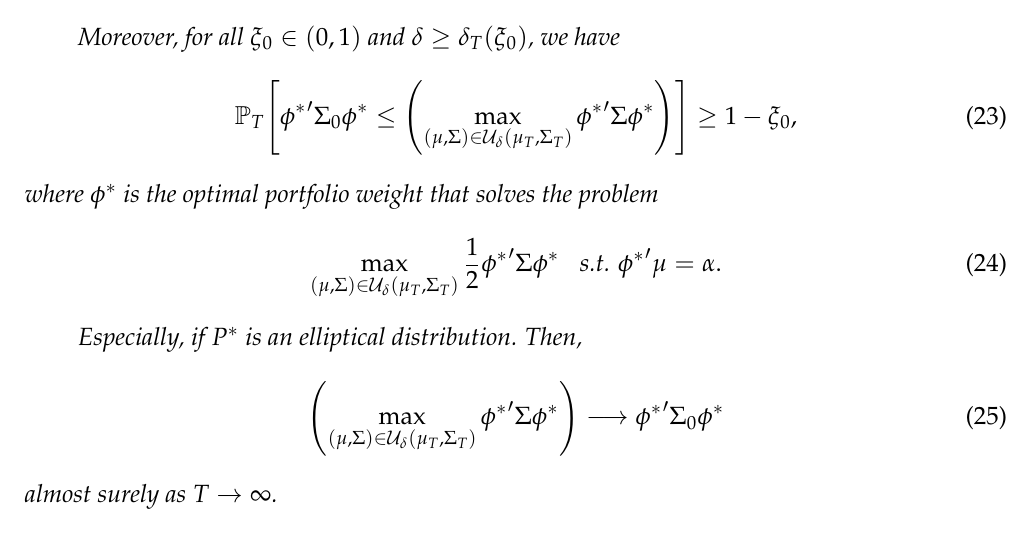
Table 1. Empirical distribution of (cid:98) δ based on various estimators of covariance.